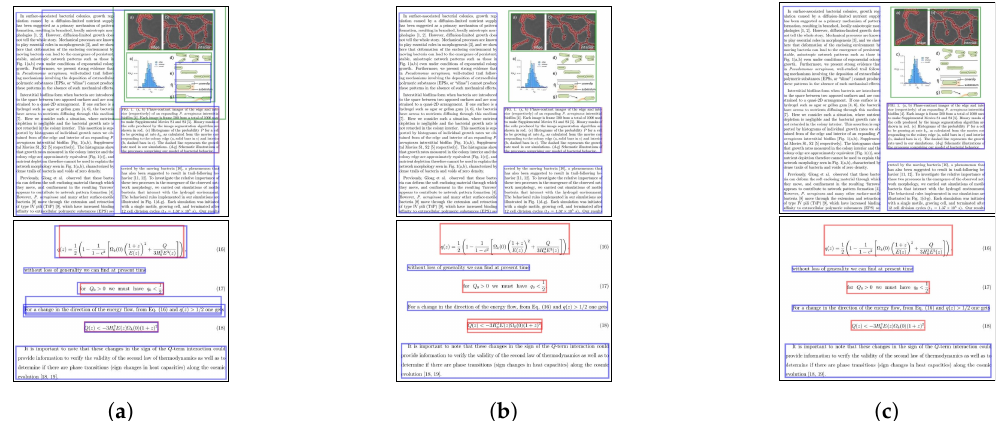
Figure 5. Detection results of DocBank [19] obtained from the baseline, Faster-RCNN+ResNet- 50+DyHead, and the Faster-RCNN+ConvNeXt+DyHead model. The bounding-box colours red, green, and blue represent equations, figures, and paragraphs, respectively. ( a ) The samples ob- tained from the standard Faster-RCNN model using ResNet-50 as the backbone, without attention. ( b ) The corresponding improved samples obtained when the attention mechanism is incorporated into the pipeline used in ( a ). ( c ) The samples obtained when ResNet-50 is replaced by ConvNeXt, and attention is added to the baseline model’s pipeline. The level of misclassifications, and the bounding-box accuracy of the detected objects is drastically improved in ( b ) just by the addition of attention. The results are further improved in ( c ), where nested detections are discarded.